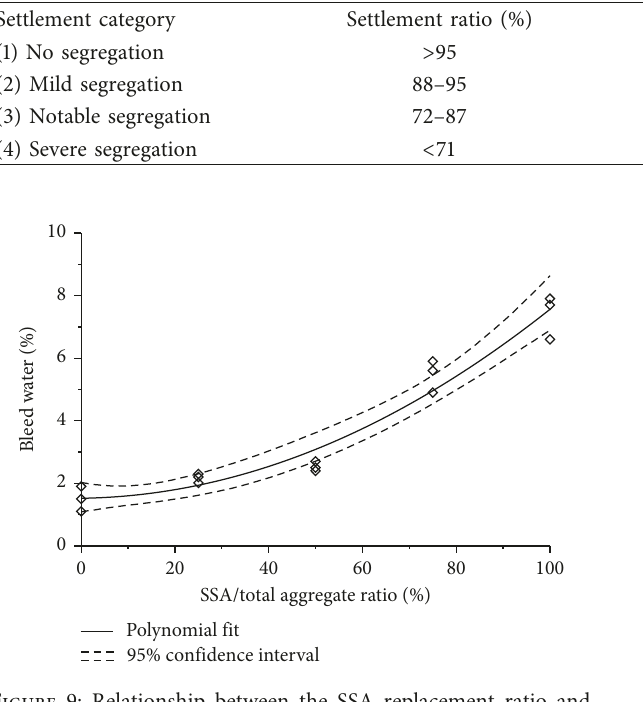
Table 7: Segregation threshold (Sonebi et al.) and classification of the tested concrete. Category for each SSA replacement ratio (average value)